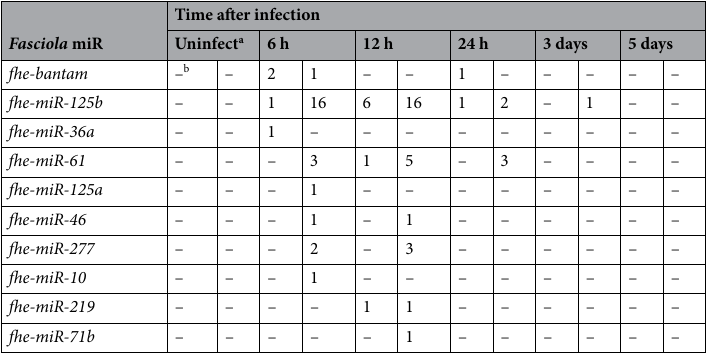
Table 1. Read numbers of known Fasciola hepatica miRNAs detected by miRNASeq in peritoneal macrophages harvested from infected mice over a time-course of 5 days. a Two biological samples were sequenced at each time point with read counts for each sample presented in columns below. b “–“ no read counts